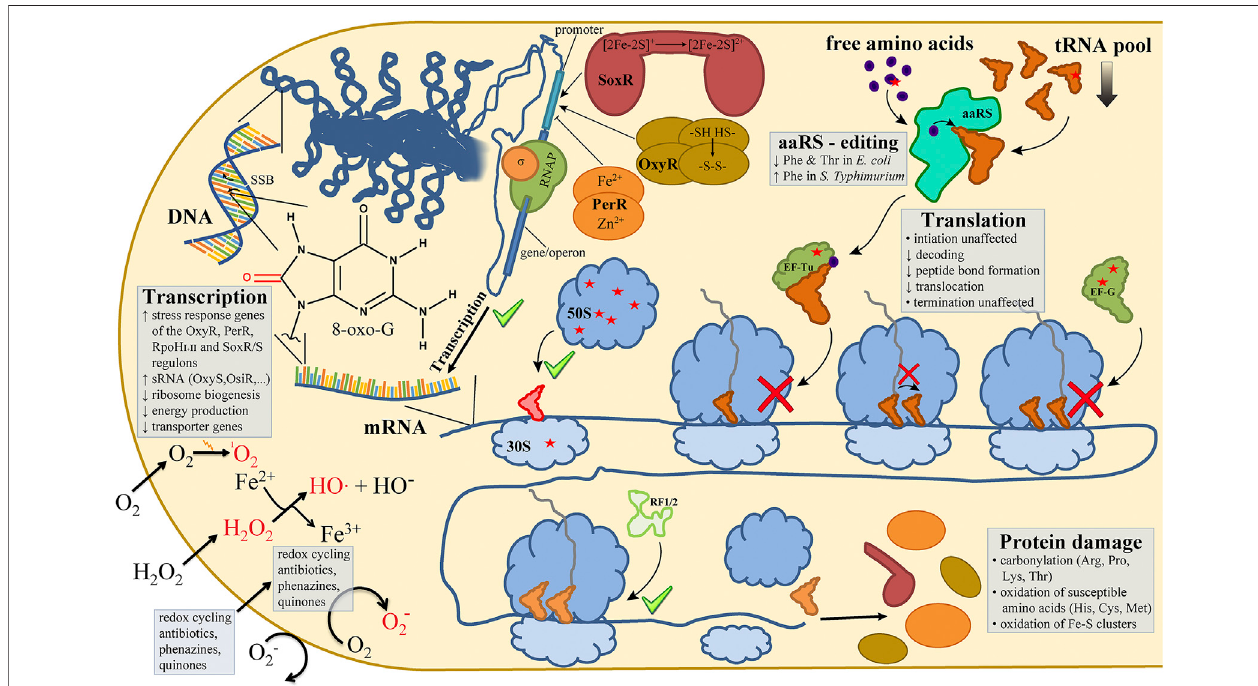
FIGURE1| Oxidativestressinbacteriaaffectseverysubstepofthecentraldogma.Inbacterialcellsthemostwidelystudiedreactiveoxygenspecies(ROS)are 1 O 2 (cid:129) (singlet oxygen), O 2 − (superoxide) and H 2 O 2 (hydrogen peroxide), with the latter giving rise to HO (hydroxyl radicals) via the Fenton reaction (lower left) . ROS- dependent oxidations of DNA nucleobases (e.g., 8-oxo-G) or DNA backbone lesions (single-strand breaks; SSB) are recognized and trigger transcriptional responses mediated by oxidative stress-induced transcription factors (e.g., OxyR, PerR, SoxR) (upper left) . Bacterial translation is affected in multiple ways by oxidative lesions (redasterisks) asobservedin thepool offreeaminoacids,inelongation factors (EF-Tu,EF-G), ribosomal proteins, and inthemain RNAspecies ofthetranslation machinery (tRNA, rRNA) (upper right and center of the fi gure) . Not necessarily expected, the sub steps of the ribosomal elongation cycle of protein biosynthesis are not affected by ROS to the same extent (center and lower right). While translation initiation and termination do not seem to be markedly inhibited (green check marks), A-sitetRNAaccommodation,peptidebondformationandEF-G-mediatedtRNAtranslocationareinhibitedbyoxidativelesions(redcrosssigns).Pleaserefertothemain text for more details on the ROS-mediated effects on the sub steps of the central